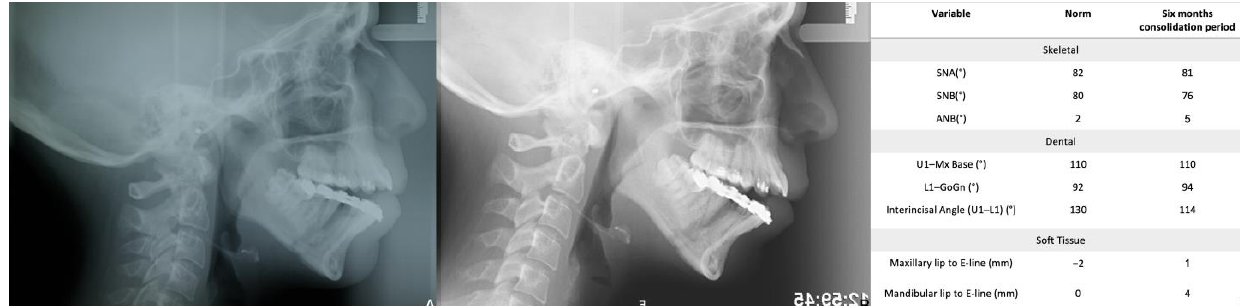
Figure 5. Orthopantomography immediately after the active period of distraction ( A ) and with six months consolidation period ( B ).